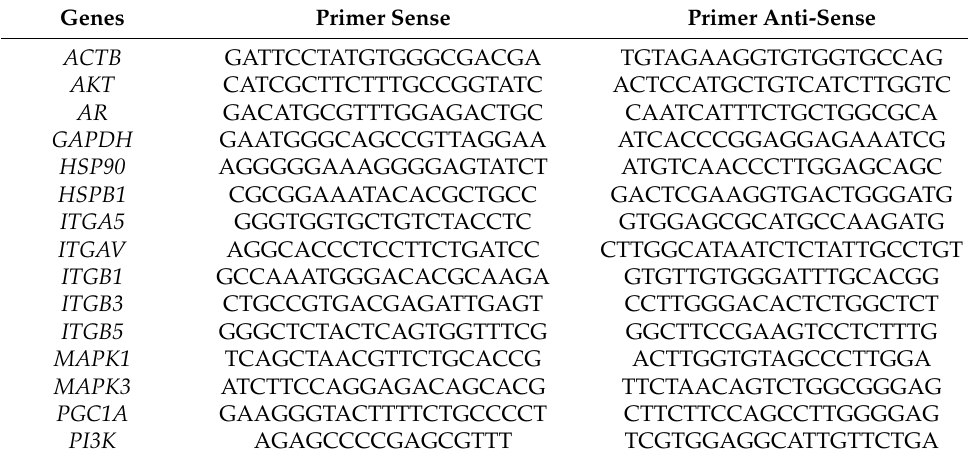
Table 1. Primers used in the RT-qPCR